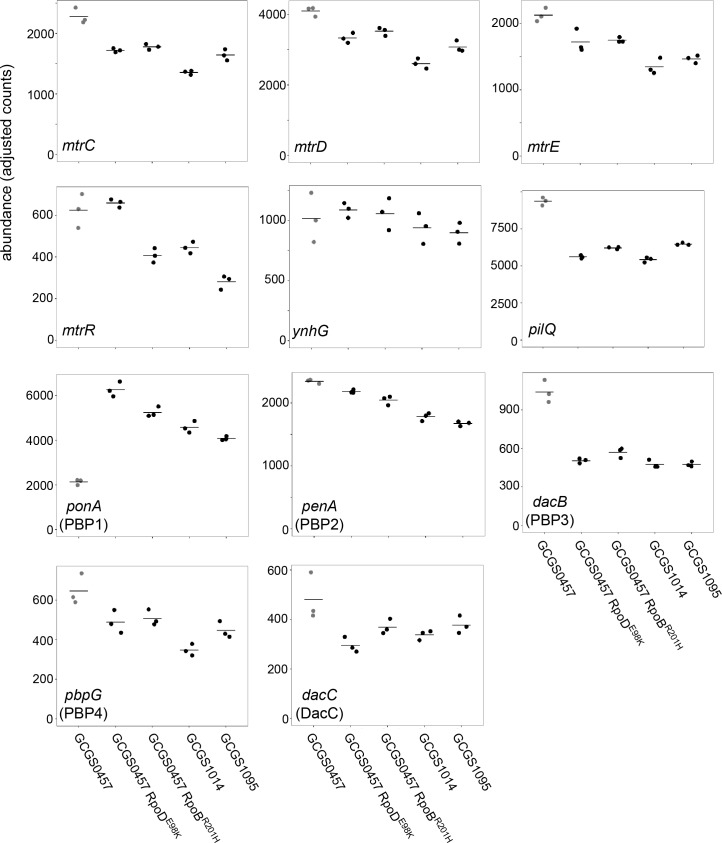
Transcript abundance of various genes in CRORS strains with RNAP mutations, exposed to sub-inhibitory ceftriaxone.Normalized abundance of various transcripts in parental isolates (GCGS0457, GCGS1095, GCGS1014) and RNAP mutant transformants, exposed to 0.008 μg/mL CRO for 90 min. Shown: mtrC, mtrD, and mtrE, which encode the components of the Mtr efflux pump; mtrR, which encodes the transcriptional repressor of the mtrCDE operon; ynhG, a putative L,D-transpeptidase; pilQ, which encodes the pilus pore subunit PilQ; and transcripts for each of the penicillin-binding proteins.